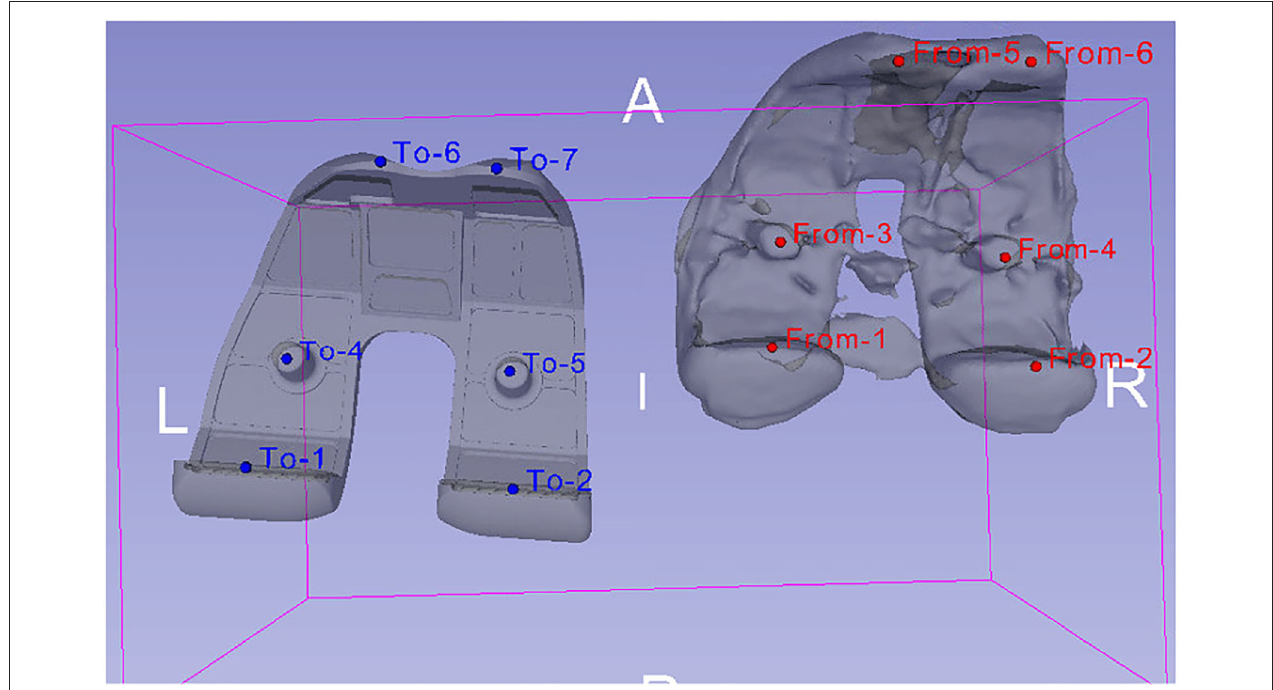
FIGURE 4 | Alignment of femoral component’s 3D model (left—obtained from 6th GCC data set) with a trial model (right), which was produced through the segmentation of patient’s post-operative CT images. The alignment was carried out by comparing the position of landmarks placed on the trial model (red “From” points) to the ones placed on the femoral component’s 3D geometry (blue “To” points).